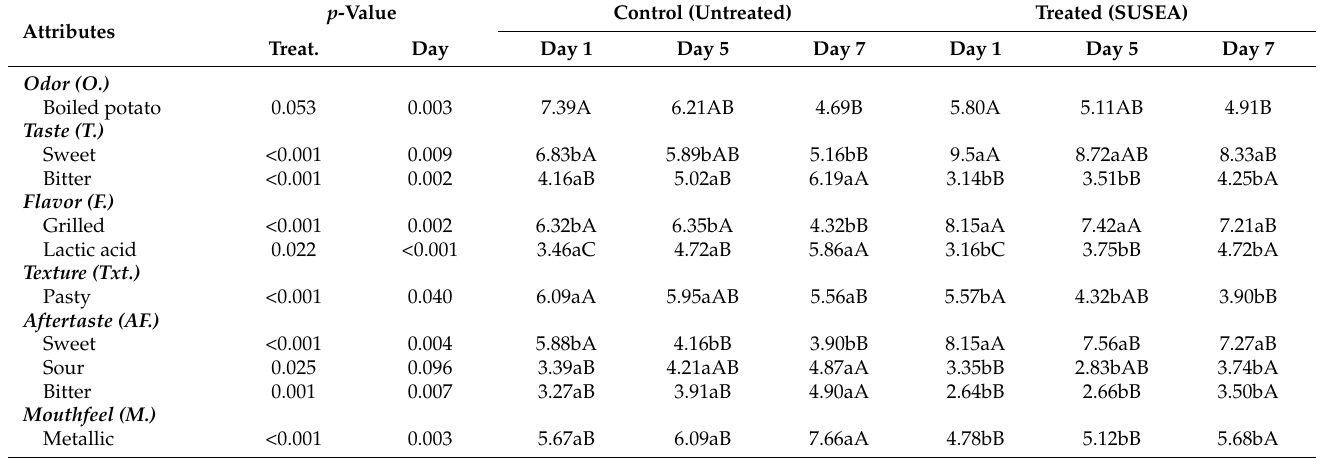
Table 5. Mean intensities (150 mm scale) of attributes varying with Treatment and storage Day ( p < 0.1), according to the factorial 2-way ANOVA model (fixed factors: Treatment, Day, Interaction: Treatment*Day). Post hoc, Fischer LSD, lowercase and capital letters indicate significant differences between treatments and storage days,